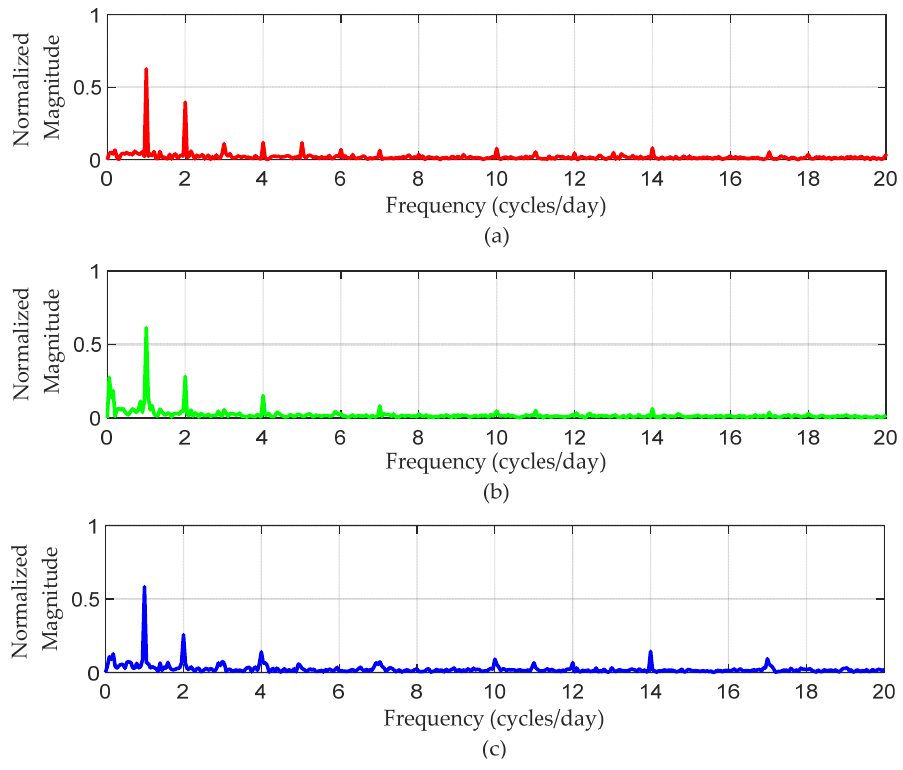
Figure 5. Normalised magnitude spectrum of the recorded SPLs using FFT: ( a ) ICU1, ( b ) ICU2, and ( c ) ICU3.